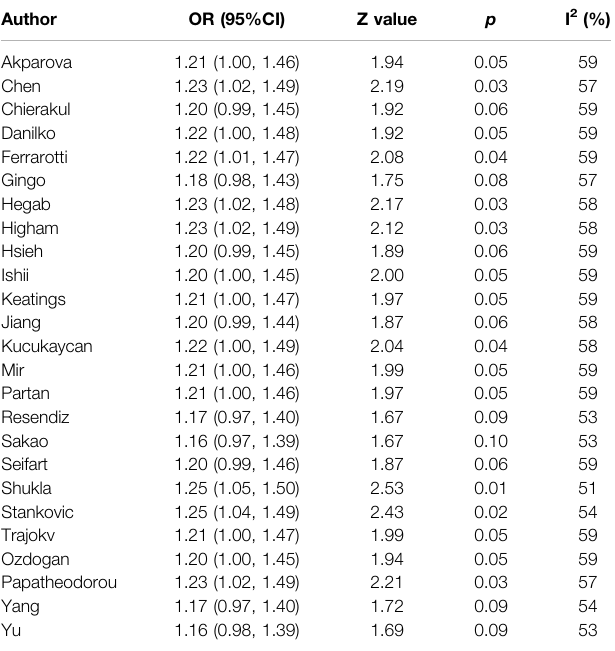
TABLE 4 | Sensitivity analysis of the association between TNF- α -308 and COPD risk, under the allelic model in overall population.; Abbreviation: CI (cid:1) con fi dence interval, OR (cid:1) odds ratio.